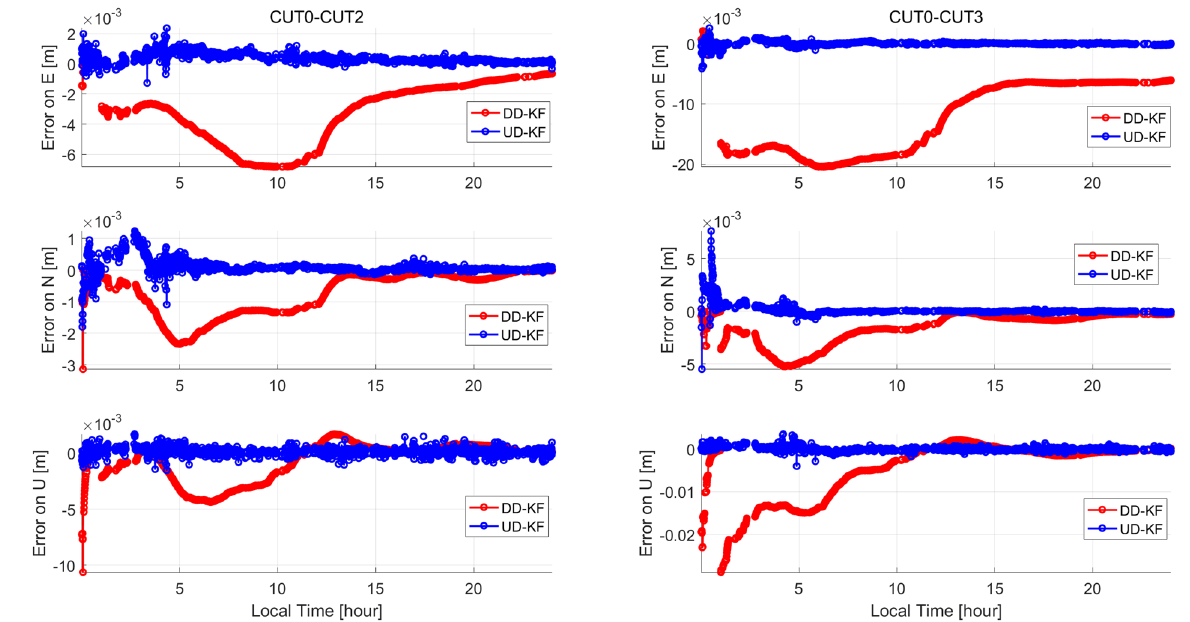
Figure 5. ENU position error for zero-baseline test of CUT00. Table 2. The RMS and STD of the positioning